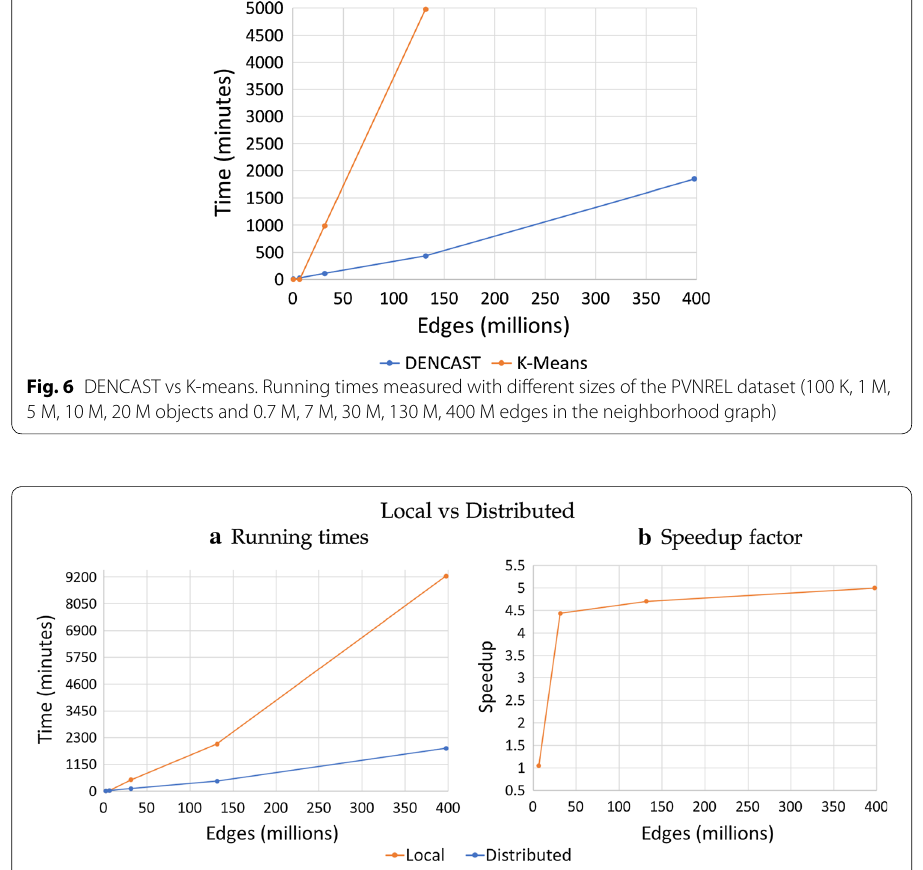
Fig. 7 DENCAST-local vs DENCAST-distributed. a Running times and b speedup factor, with different sizes of PVNREL (100 K, 1 M, 5 M, 10 M, 20 M objects and 0.7 M, 7 M, 30 M, 130 M, 400 M edges in the